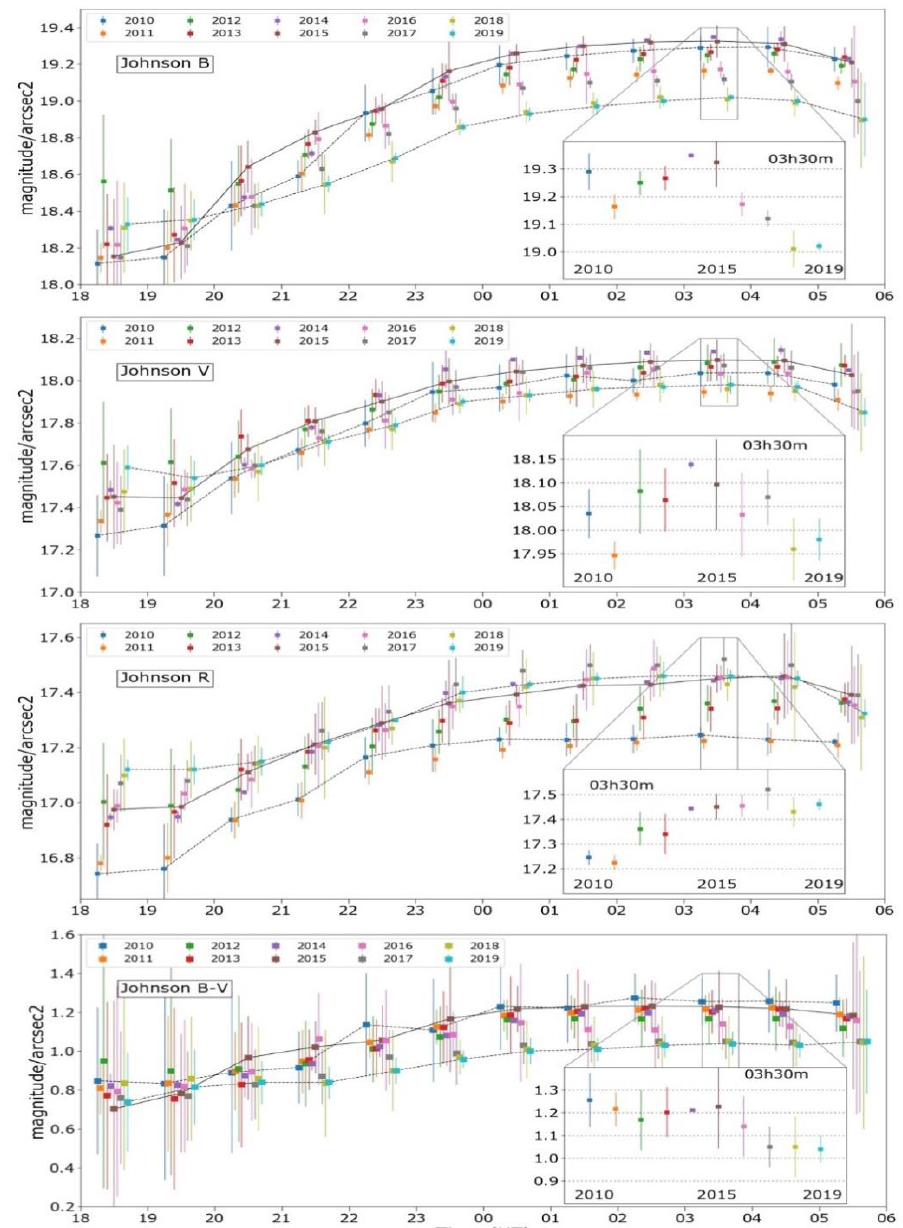
Figure 18. Change in position and shape of the curves showing the evolution of Johnson B, V, R and B-V color index throughout the night in winter. Data are grouped by year and binned in hourly intervals. The data points have been displaced on the x -axis to avoid crowding. Inset shows detail for the 3 h 30 m evolution. The night sky brightness variability is depicted with the Inter Quartile Range (IQR).